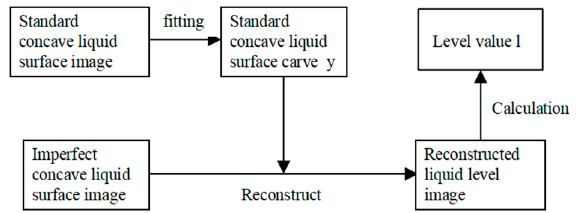
Figure 14. A block diagram for the curve fitting and reconstruction algorithms applied to modeling the concave meniscus.